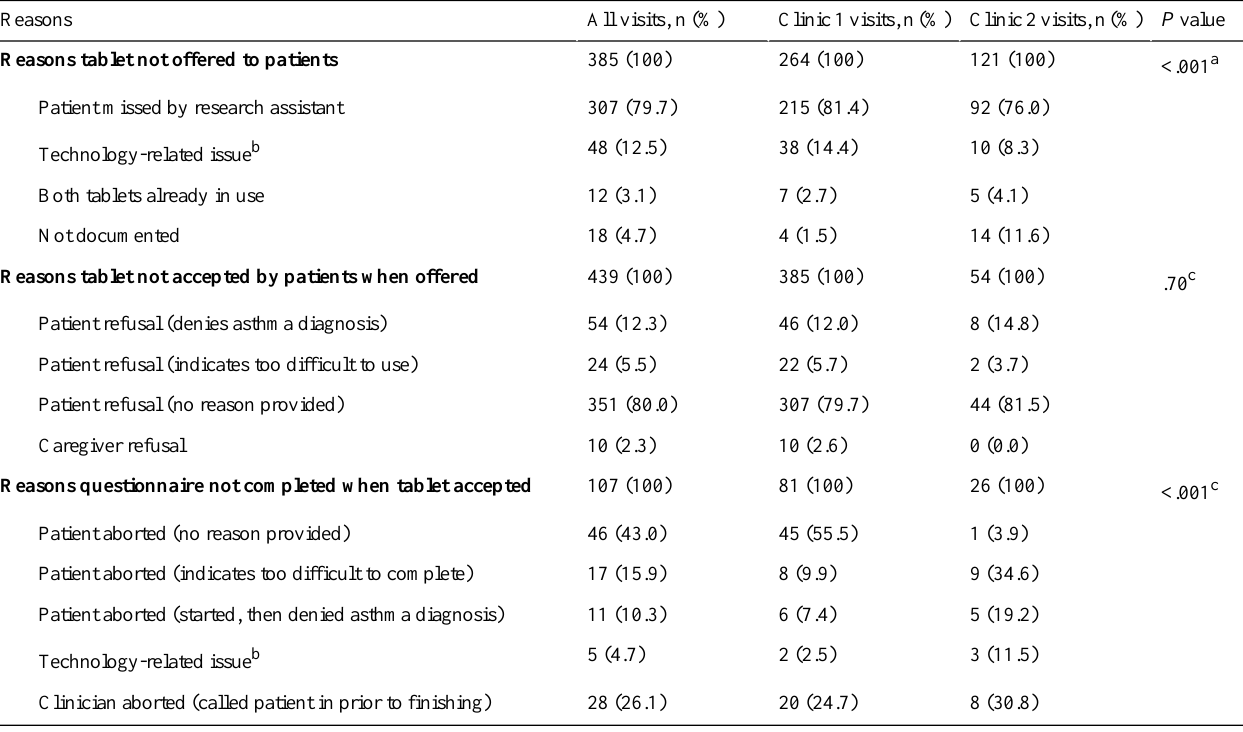
Table 2. Reasons for failed tablet uptake and